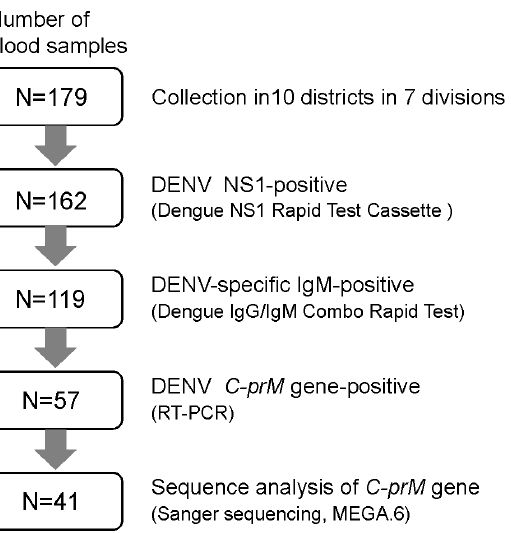
Figure 2. Flowchart representing the study of dengue virus and antibody with the use of blood samples in Bangladesh, 2019.